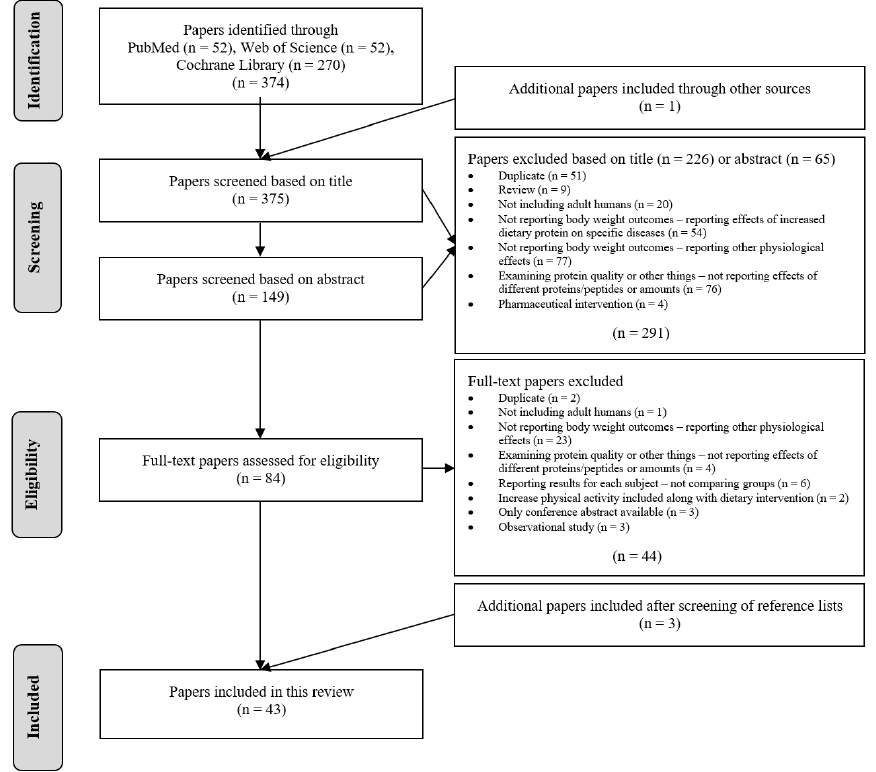
Figure 1. PRISMA flow chart explaining the literature selection process after systematic literature searches in PubMed, Web of Science and Cochrane Library, identifying studies potentially eligible for inclusion and available as of 1 September 2021.